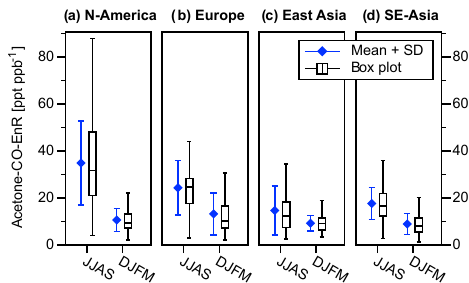
Figure 9. Mean and standard deviation (SD) (blue) and box plots (black) of EnR summer (JJAS) and winter (DJFM) distributions for four selected regions as shown in Fig. 8. In the underlying dis- tributions, individual EnRs have been duplicated along the hourly waypoints of the assigned 5-day back trajectories to consider the residence time of the samples above the region. The numbers of individual, unique EnRs as well as percentages related to the total number of EnRs are given in Table